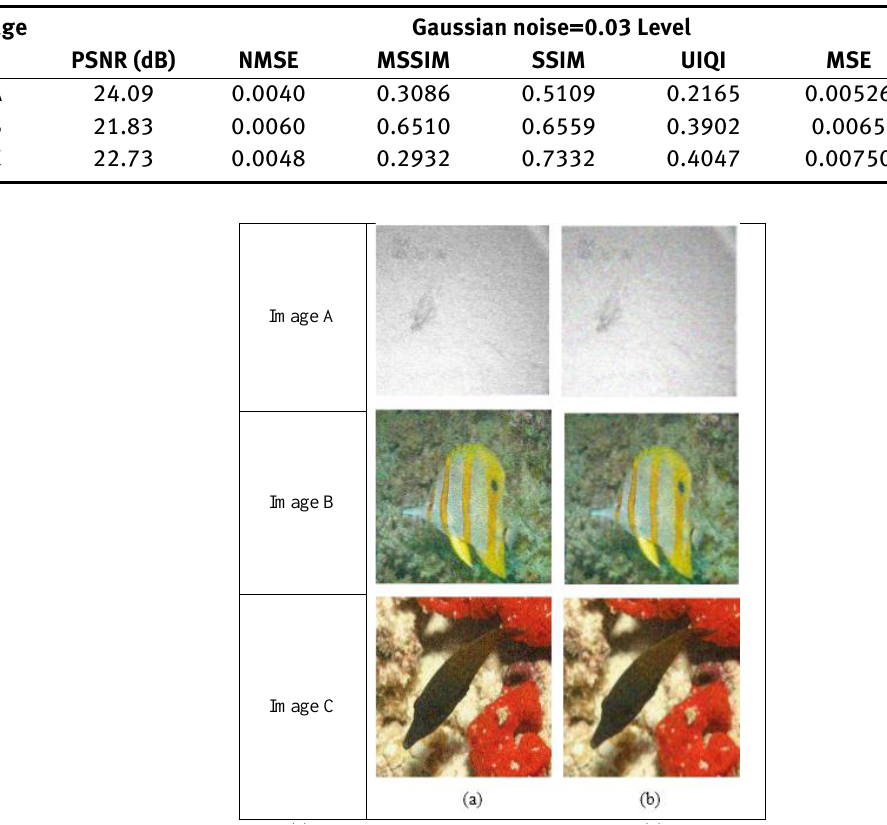
Figure 7: (a) Images with 0.03 Level Gaussian noise, (b) Denoised